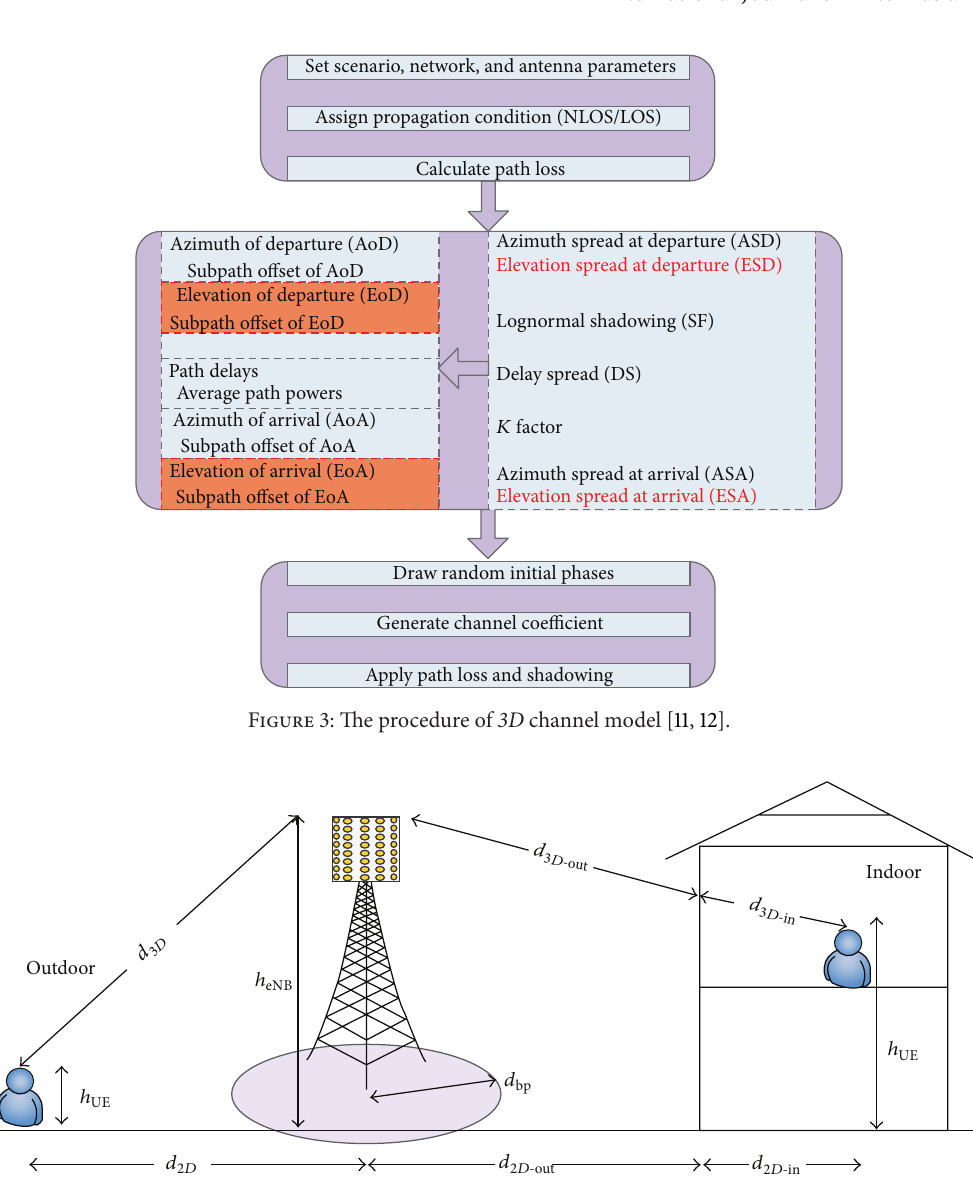
Figure 4: Illustration of path loss